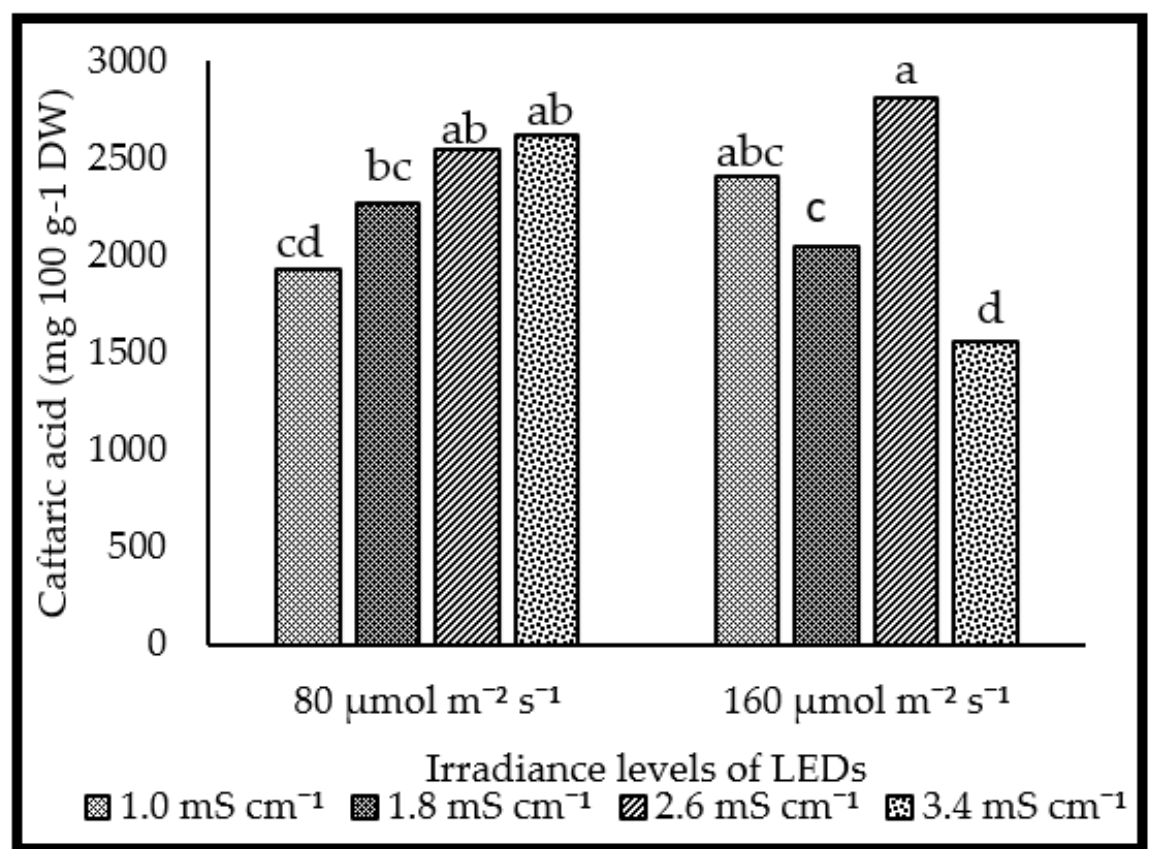
Figure 8. Interaction effect of LED irradiance levels and nutrient solution EC on caftaric acid in lemon